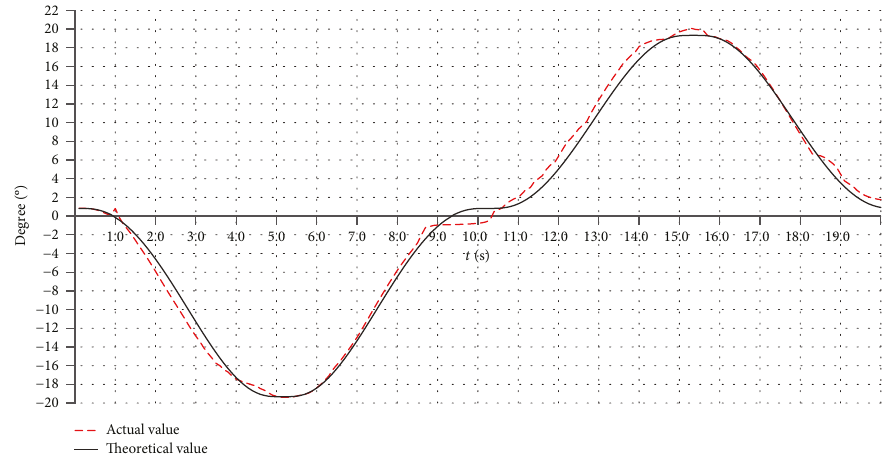
Figure 24: The working angles (from -20 ° to +20 ° ) for the varus/valgus rehabilitation motion.